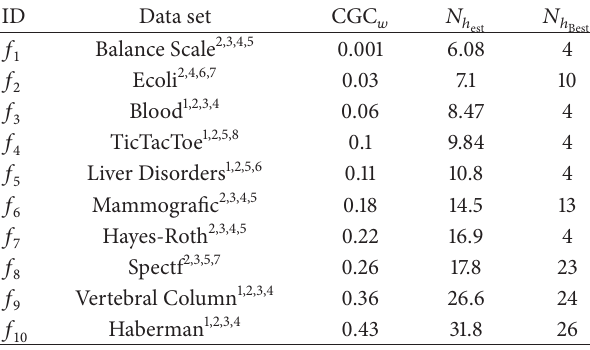
Table 1: Results of the application of the model constructed by approximating the CGC of 10 benchmark data sets from the UCI